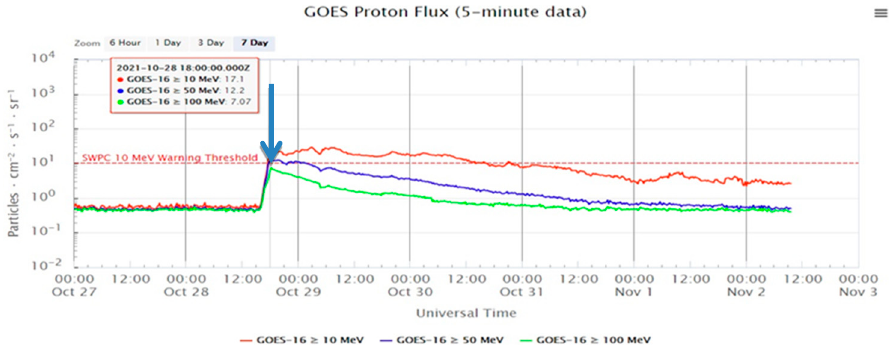
Figure 9. Alert signal issued by Space Weather Prediction Center (SWPC) of NOAA.